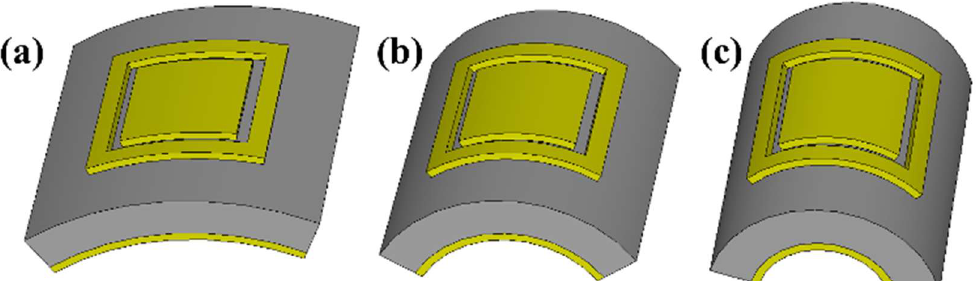
Figure 3. Schematic diagram of bending analysis of the proposed MMA over the radii of different arbitrary cylinders, ( a ) R = 10 mm, ( b ) R = 2 mm, and ( c ) R = 1.5 mm. In this fig., the smaller the value of the radius (R), the larger the bending condition.